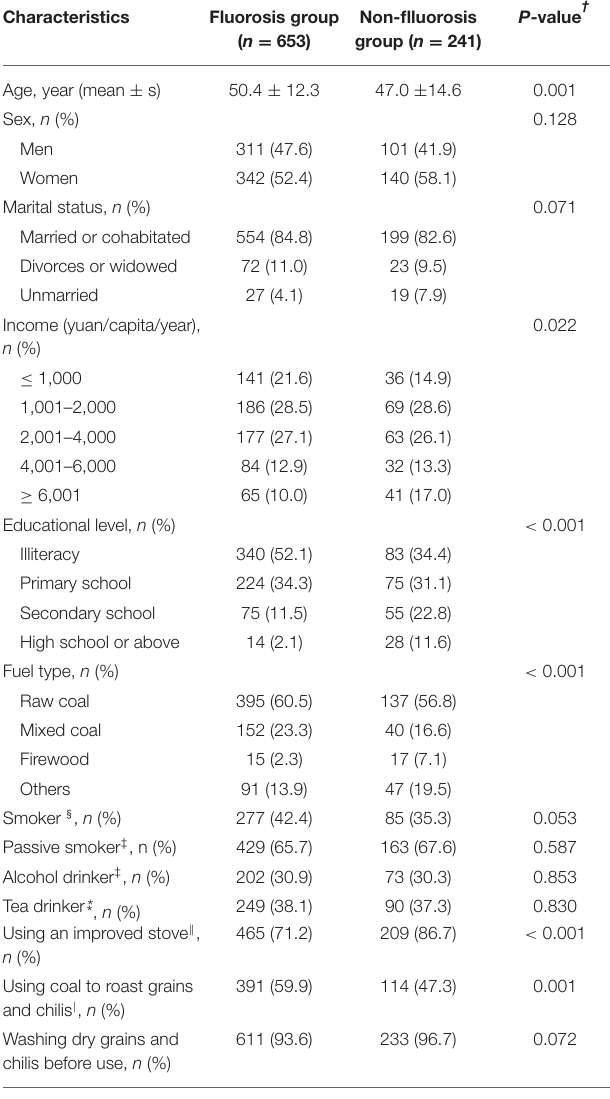
TABLE 1 | Socio-demographic characteristics and selected risk factors of the participants in coal-burning fluorosis area in Guizhou.